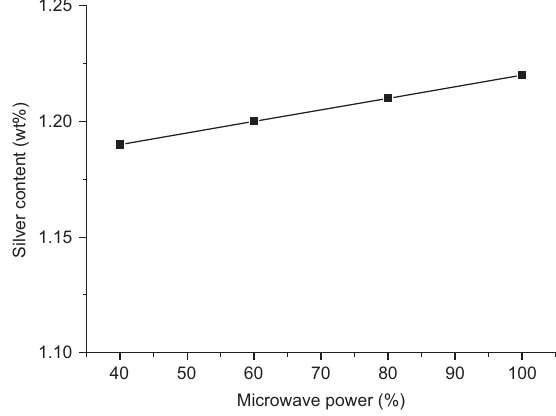
Figure 2 Effect of microwave irradiation time on the silver content of Ag-MMT. AgNO concentration = 0.1 m , microwave power = 100 % . 3